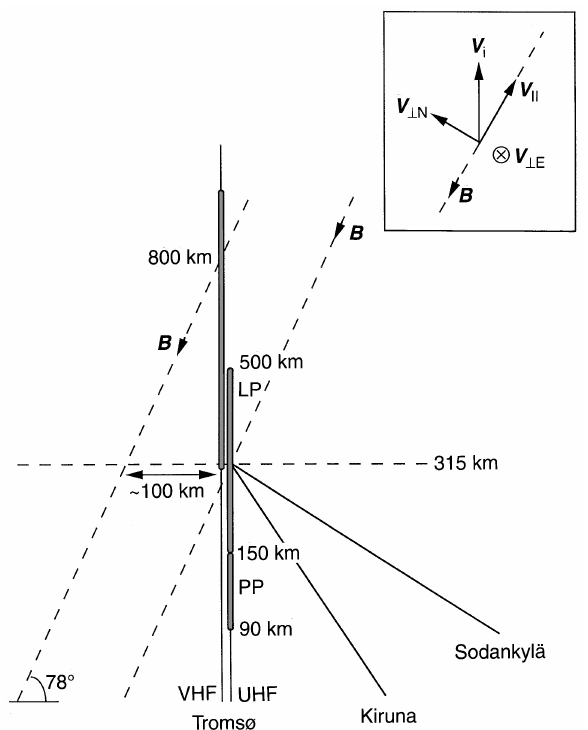
Fig. 1. Schematic showing the configuration of Special UK EIS- CAT Program UFIS. Shaded areas indicate the altitude ranges of observations of the UHF and VHF radars (LP " long pulse, PP " power profile). Inset shows parallel, perpendicular and verti- cal components of velocity with respect to the